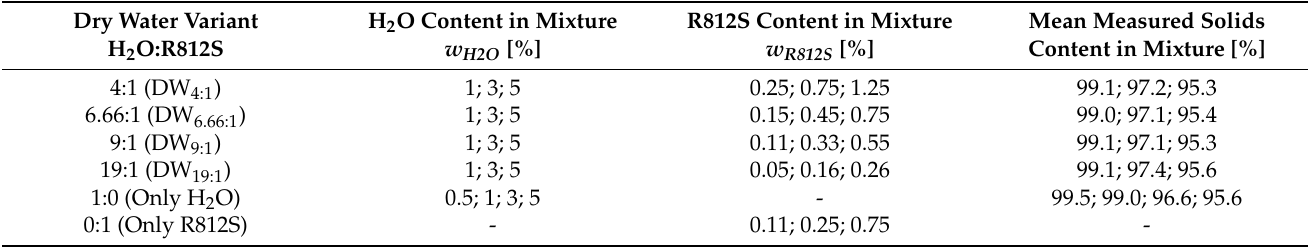
Table 2. Mixing Quantities by Weight Percentage of Aggregate Sand